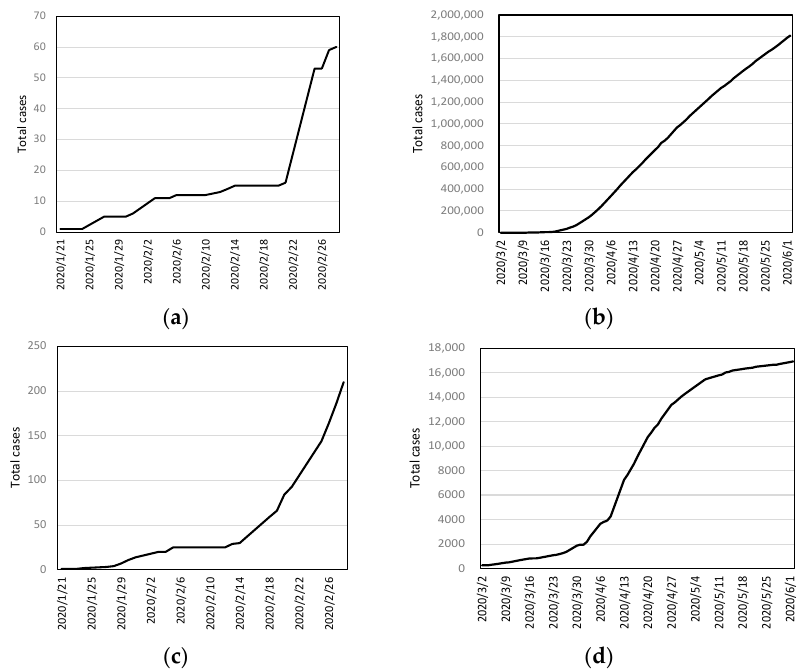
Figure 4. Accumulative number of COVID-19 cases in the US and Japan, ( a ) COVID US before March